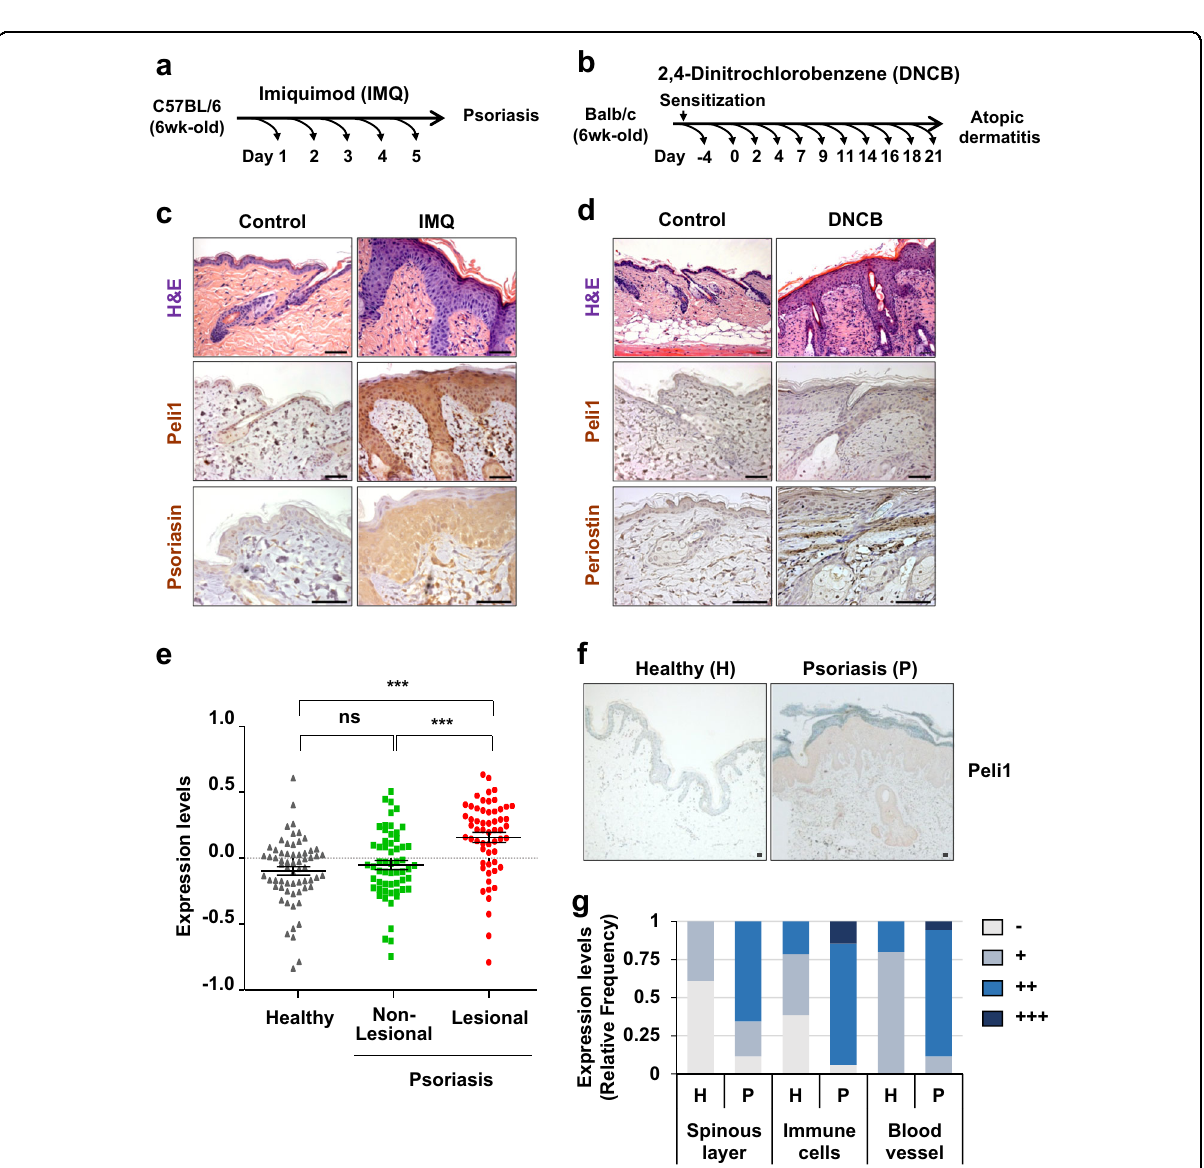
Fig. 1 Correlation between Peli1 expression and the development of psoriasis-like skin in fl ammatory disease. a Psoriasis-like skin in fl ammation was induced by topical application of imiquimod (IMQ) cream daily for six consecutive days. Control (Cont) indicates equivalent volume of Vaseline treatment. b To induce atopic dermatitis-like symptoms, dinitrochlorobenzene (DNCB) was topically applied to BALB/c mice. One day after dorsal hair removal, 1% DNCB was applied. Five days after dorsal hair removal, 0.2% DNCB was applied as described in the “ Materials